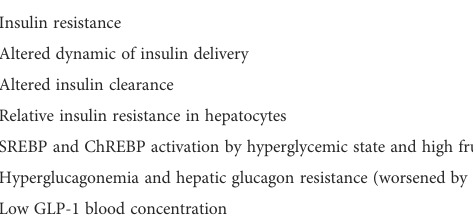
TABLE 1 Comparison of NAFLD Pathophysiology mechanisms between in T1D and T2D. NAFLD pathophysiological mechanisms T1D Insulin resistance + +++ Altered dynamic of insulin delivery ++ Altered insulin clearance +++ Relative insulin resistance in hepatocytes ++ +++